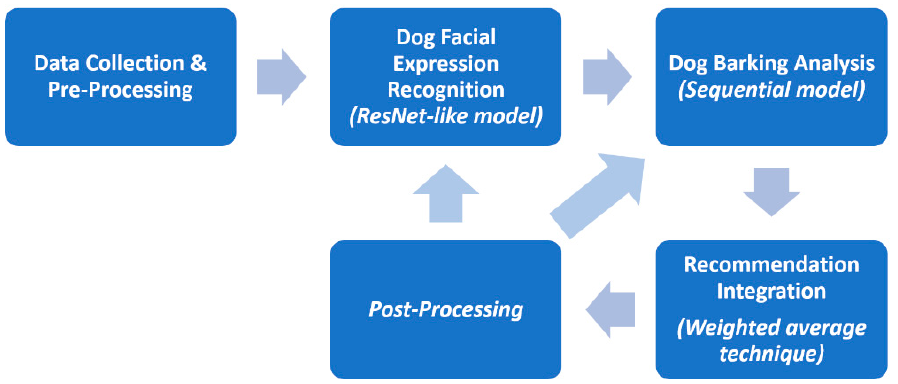
Figure 2. The overall framework of the proposed affective recommender.